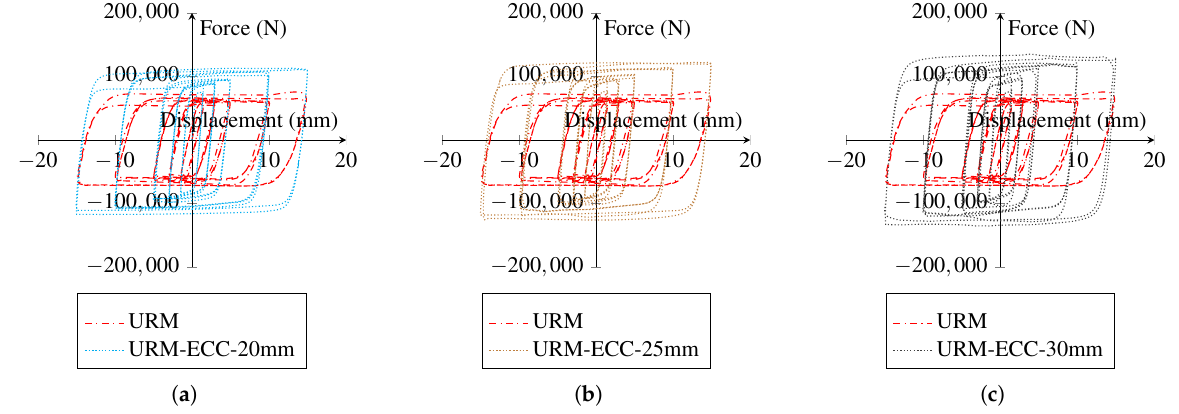
Figure 18. Effect of variation of the thicknesses value of ECC sheet on the hysteresis of the masonry wall: ( a ) 20 mm; ( b ) 25 mm; ( c ) 30